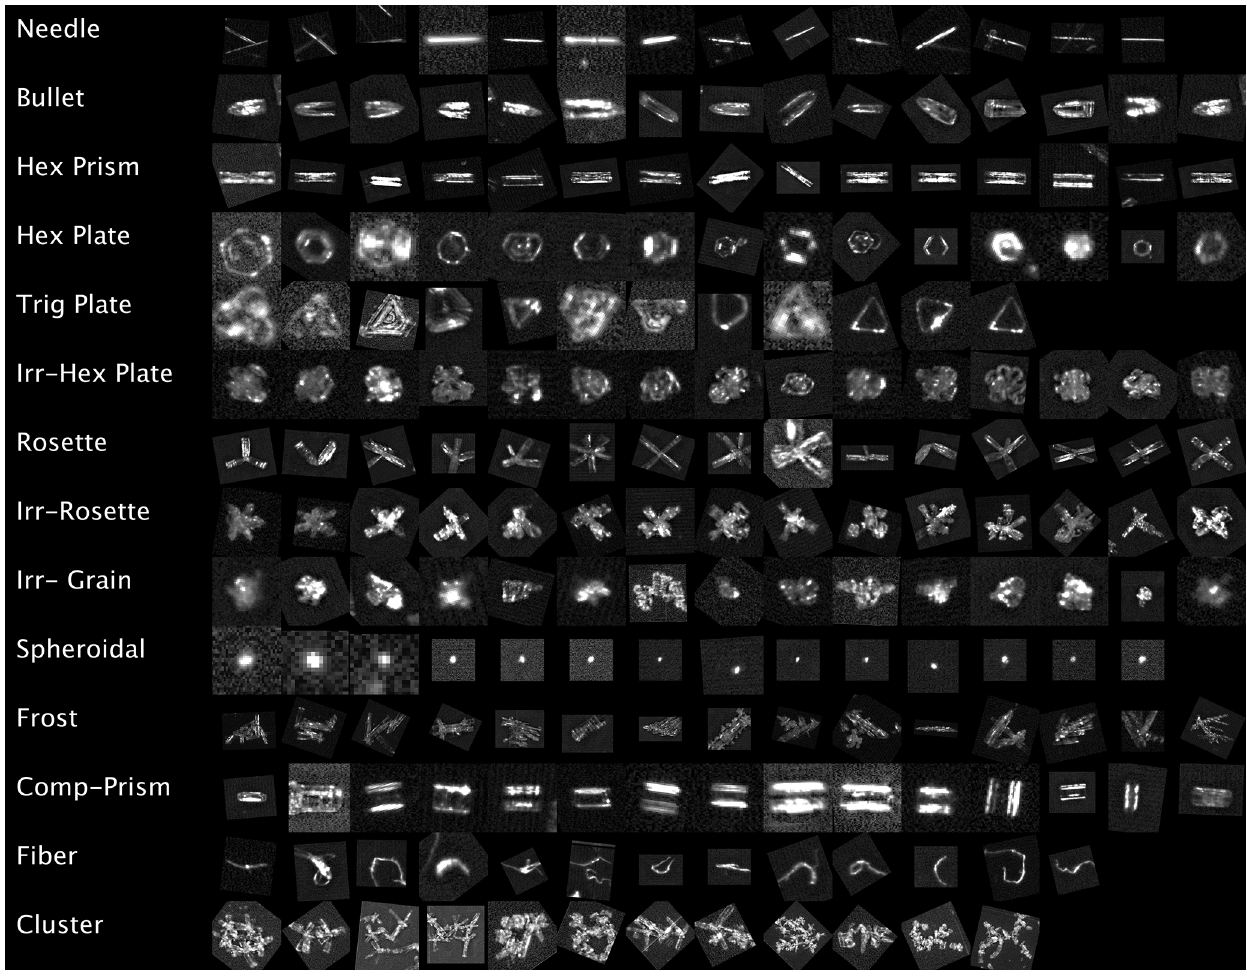
Figure 14. A sample of ICE-CAMERA images of the 14 classes of ice particles used to train the CNN.